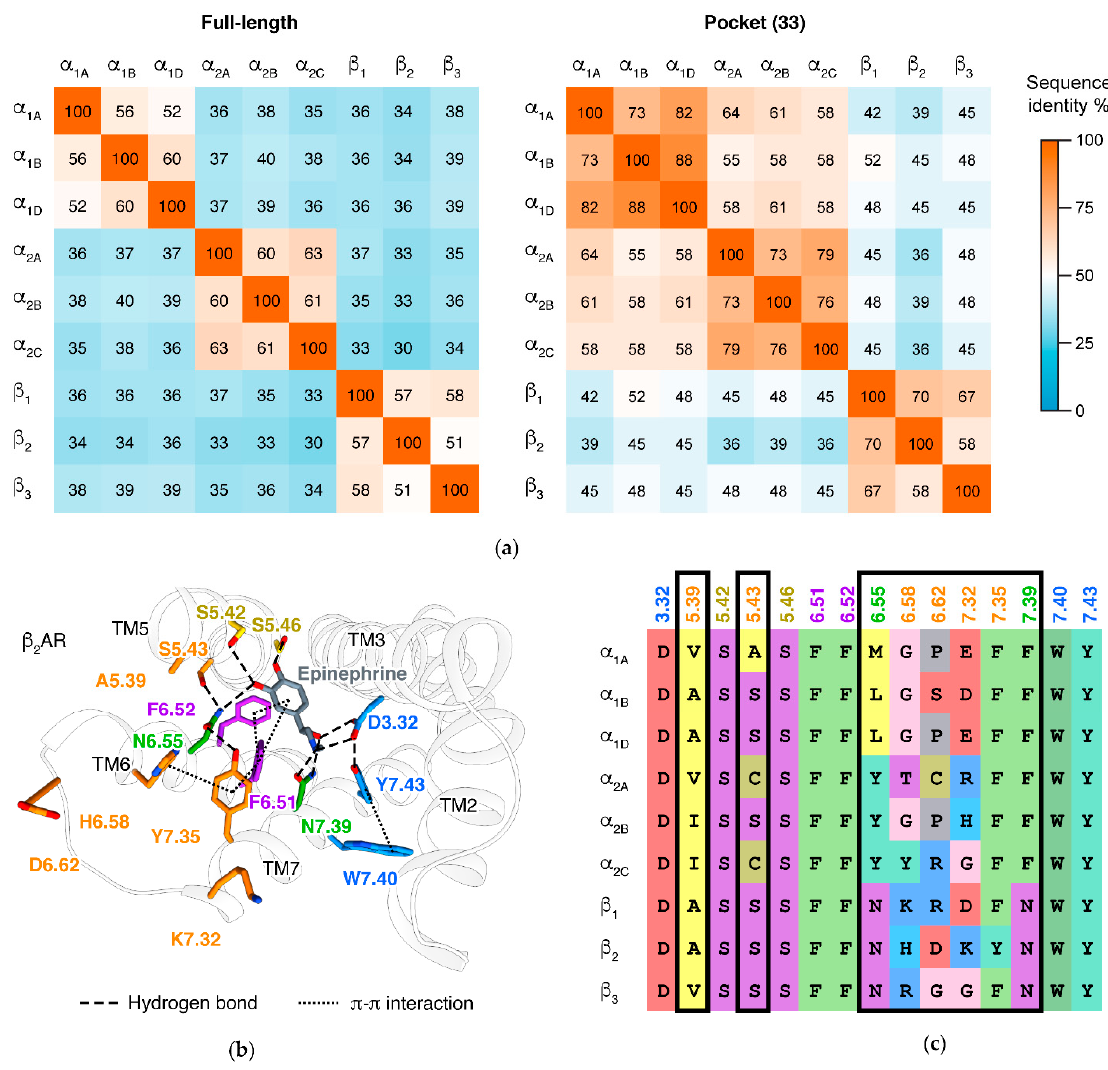
Figure 3. Comparison of adrenergic receptor major types and subtypes. ( a ) Sequence identity matrices of adrenergic receptors at full-length sequence (based on multiple sequence alignment generated with MAFFT v7.299b [30]) or pocket residues (33 residues: 2.61,64–65; 3.28–29,32–33,36–37; 45.50–54; 5.38–39,42–43,46; 6.48,51–52,55,58–59,62; 7.30,32,35–36,39– 40,43). ‘Pocket’ is the cavity at the extracellular side of a GPCR. ( b ) Key interactions of endogenous ligand epinephrine in orthosteric site of β 2 AR/epinephrine (PDB: 4LDO [31], coloring scheme the same to Figure 2a). ( c ) Alignment of key residues for moiety recognition or type selectivity (residue BWN colored in the same scheme to Figures 2a and 3b) in all the adrenergic receptors members (generated from GPCRdb plot [16], residues colored for property: red, negatively charged; blue, positively charged; yellow, hydrophobic; blue, aromatic; magenta, hydrophilic; pink, glycine; gray, proline).